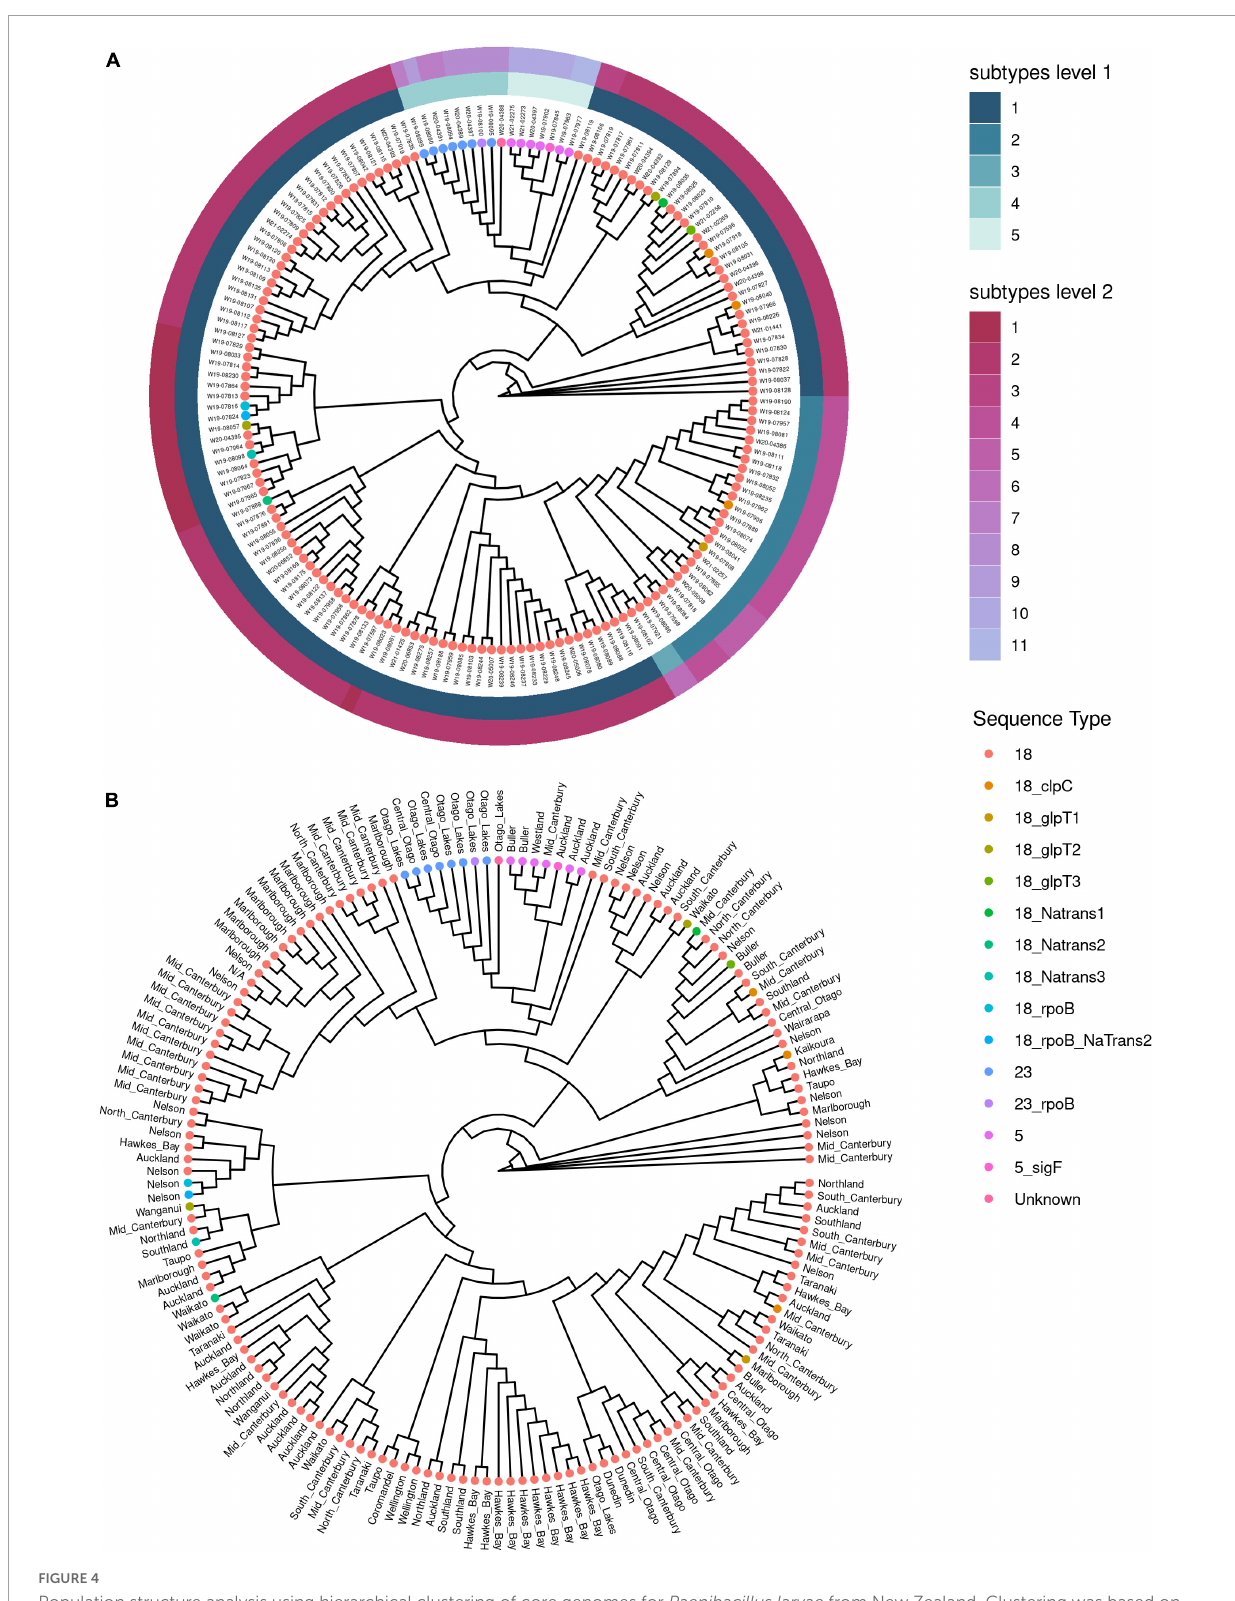
FIGURE4 Population structure analysis using hierarchical clustering of core genomes for Paenibacillus larvae from New Zealand. Clustering was based on analysis of single nucleotide polymorphisms. (A) Cladogram shown with subtypes assigned by hierarchical clustering analysis using RhierBAPS. Sequence types (ST) are coded by color for each isolate, and annotated with the unique genome identifier. (B) Cladogram by hierarchical clustering analysis using RhierBAPS without subtype assignment, and with the region of New Zealand annotated for each